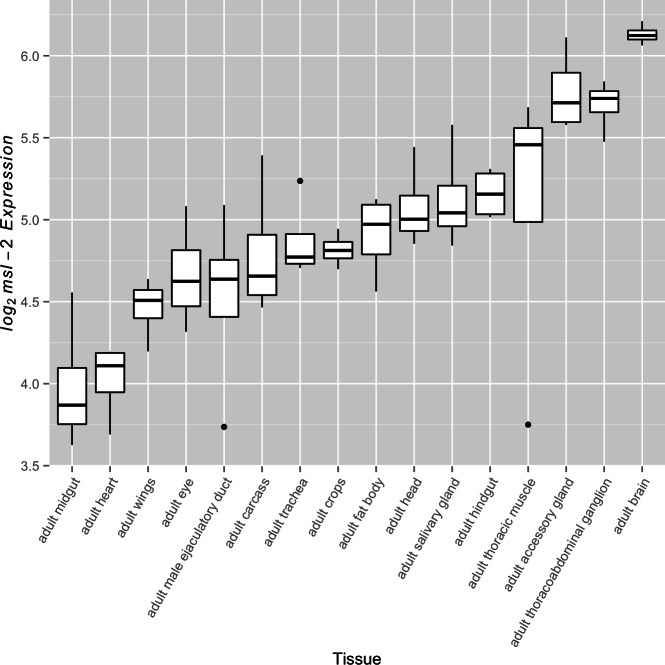
msl-2 expression variation among somatic tissues.msl-2 expression estimates were retrieved for all four FlyAtlas replicates for each tissue. Tissues are sorted by their median log2
msl-2 intensity among the FlyAtlas replicates.